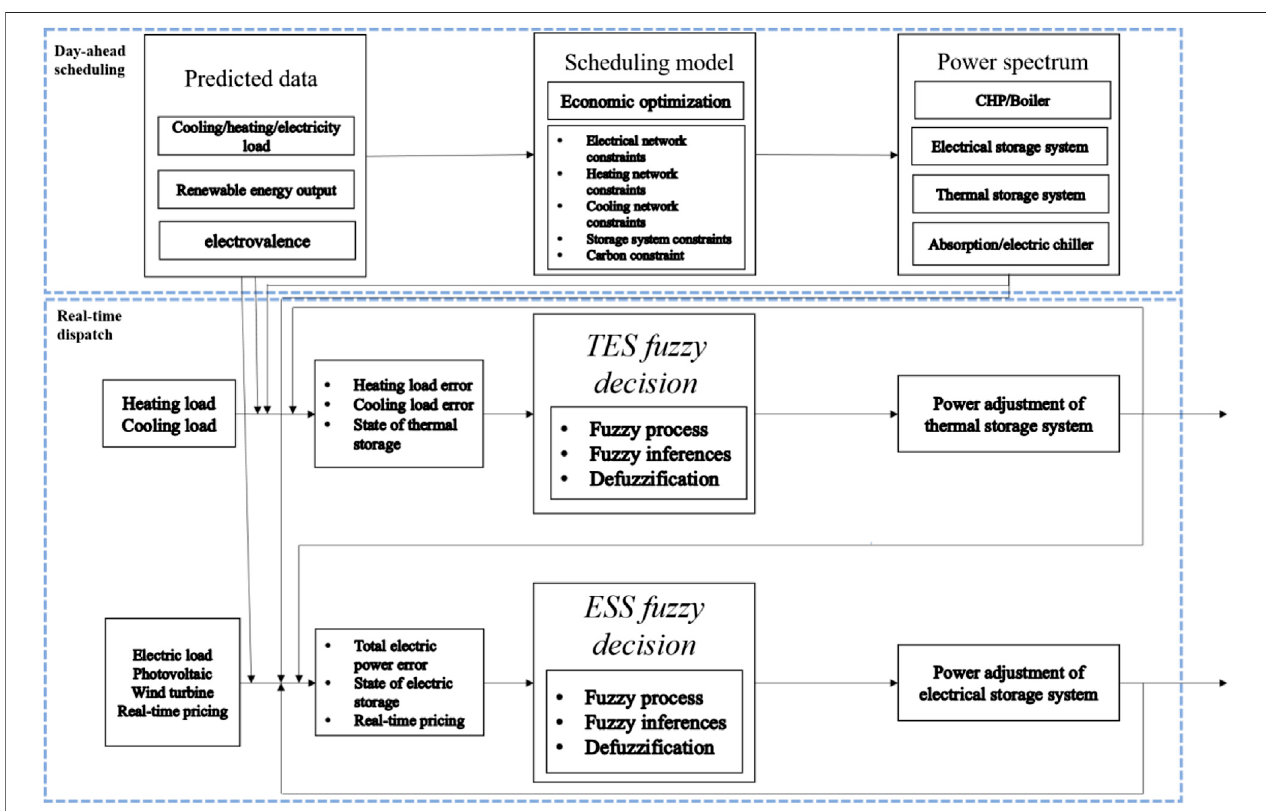
FIGURE 2 | Integrated energy system energy optimal